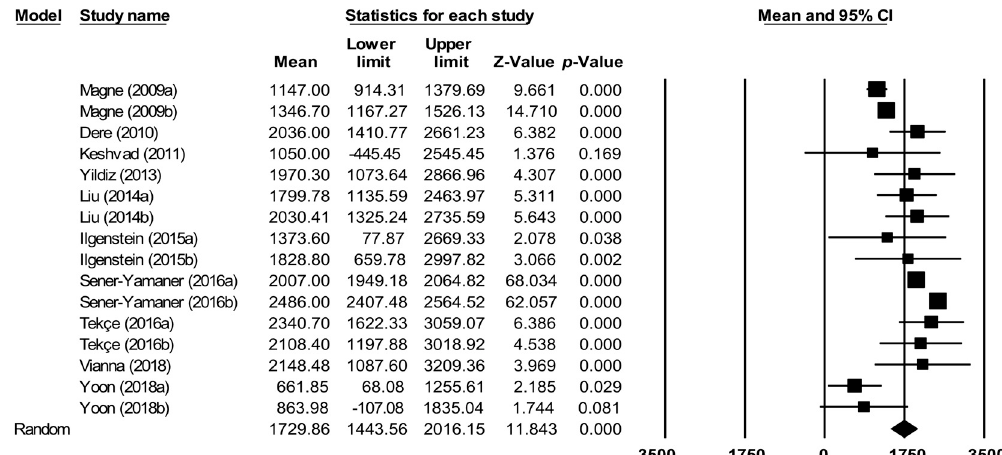
Figure 3. Forest plot of overall meta-analysis of fracture resistance (in Newtons) of restorations (inlays, onlays, and overlays) fabricated from different materials. The size of the square represents the weight of each study and the diamond represents the combined results of the meta-analysis. CI is the 95% confidence interval of the mean between a lower and an upper limit.